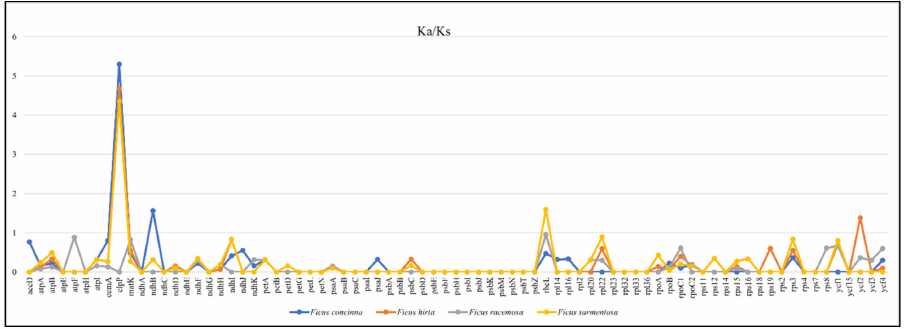
Figure 13. The Ka/Ks ratio of CDS genes from Ficus populifolia against Ficus concinna , Ficus hirta , Ficus racemosa , and Ficus sarmentosa